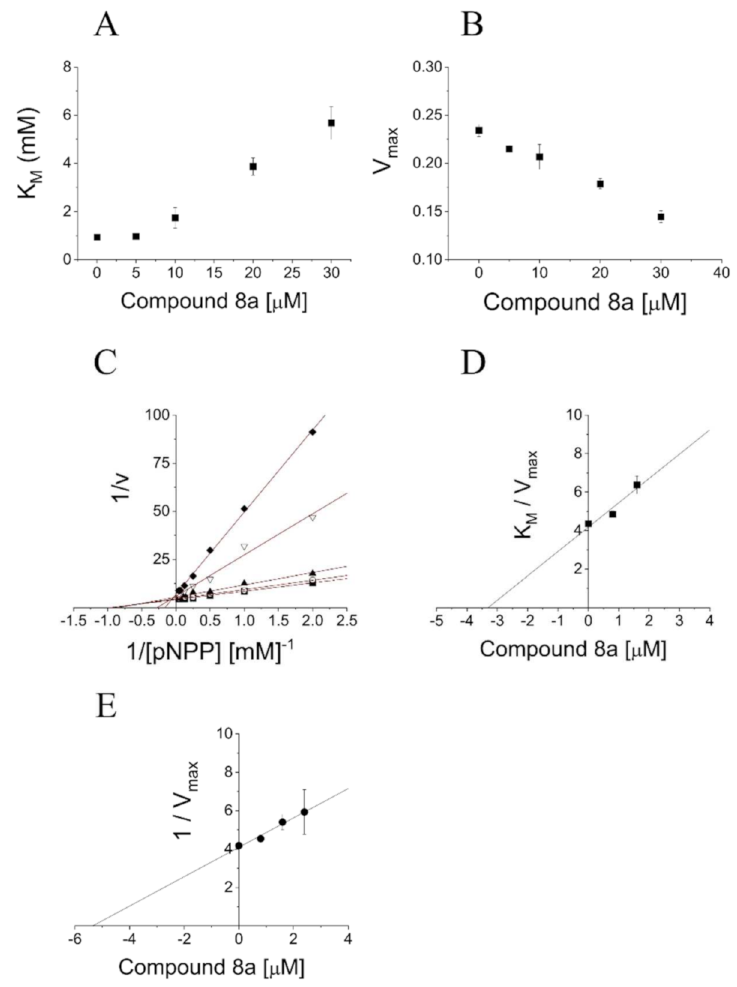
Figure 7. Kinetic characterization of 8a as PTP1B inhibitor. The concentrations of compound 3 used were 0 ( (cid:4) ), 5 ( ), 10 ( (cid:78) ), 20 ( (cid:53) ) and 30 ( (cid:7) ) µ M. Dependence of K M ( A ) and V max ( B ) from the inhibitor (cid:35) concentration. Lineweaver-Burk graph ( C ). Bars represent the standard deviations of the means from at least three independent measurements (if not present, they are within the symbol’s size). Secondary plots: K M /V max ( D ) and 1/V max ( E ) versus the inhibitor concentration, respectively. The intercept of straight line with the “x” axis in Figure D represents the Ki value, while the intercept of straight line with the “x” axis in Figure E represents the Ki (cid:48) value (Ki (cid:48) = α Ki).